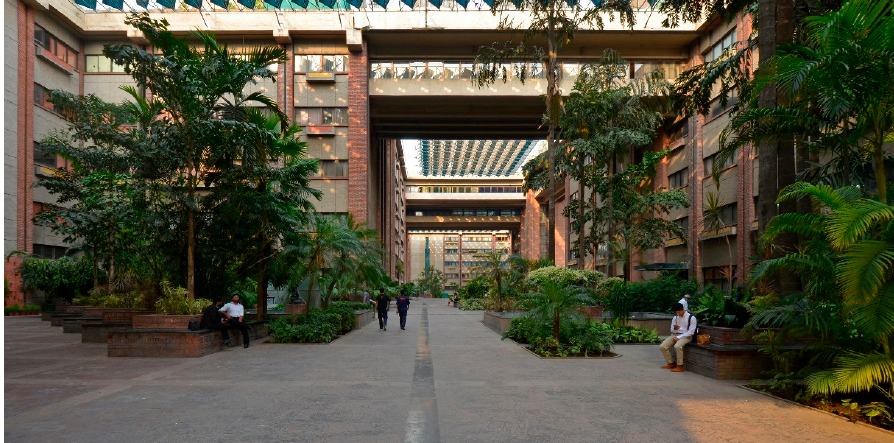
Figure 17. Garden courts between building volumes of the India Habitat Centre (Photo: Author).